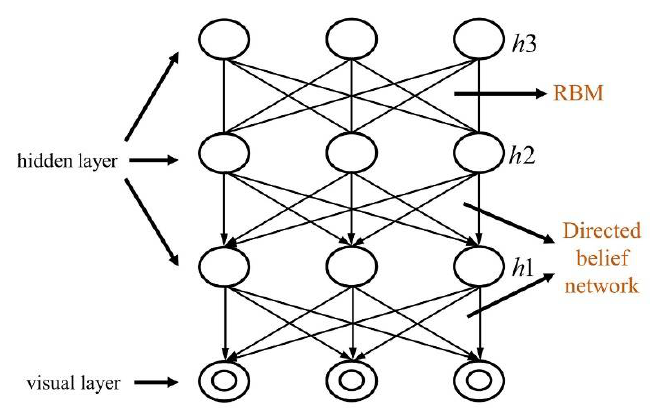
Figure 2. Deep belief network (DBN).